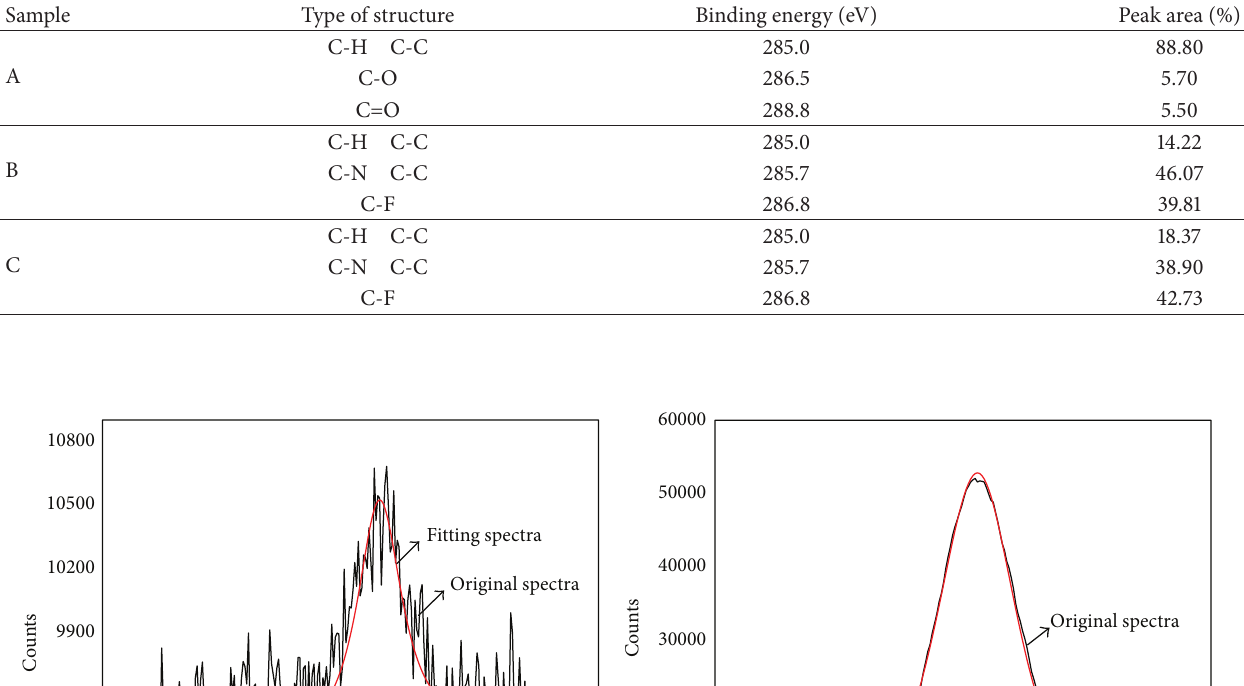
Table 3: XPS results of samples adsorbing FW-134 calculated by Gauss method.